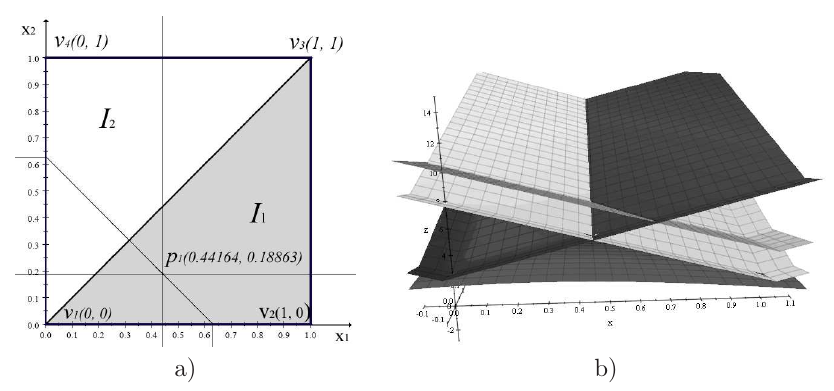
Figure 1. a) Projection of intersection lines; b) Visualization of upper bounding